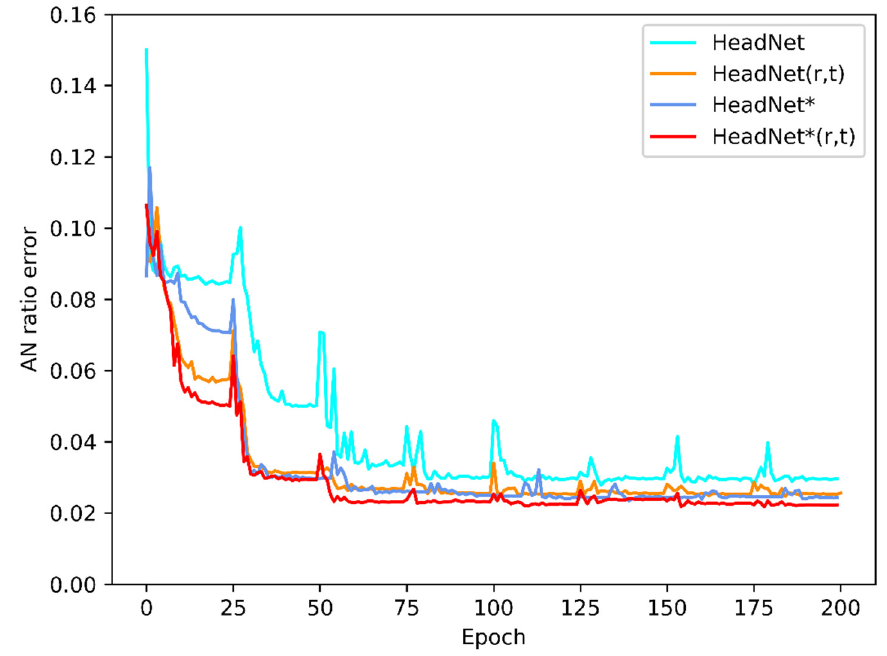
Figure 4. Changes in AN ratio error during model training: AN ratio error decreased as the epochs increased.